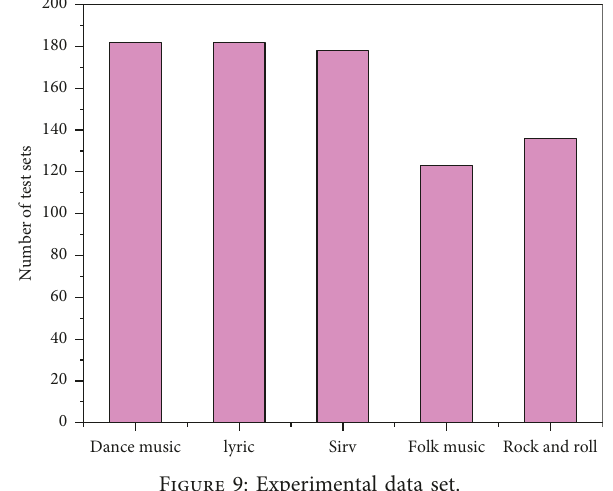
Figure 9: Experimental data